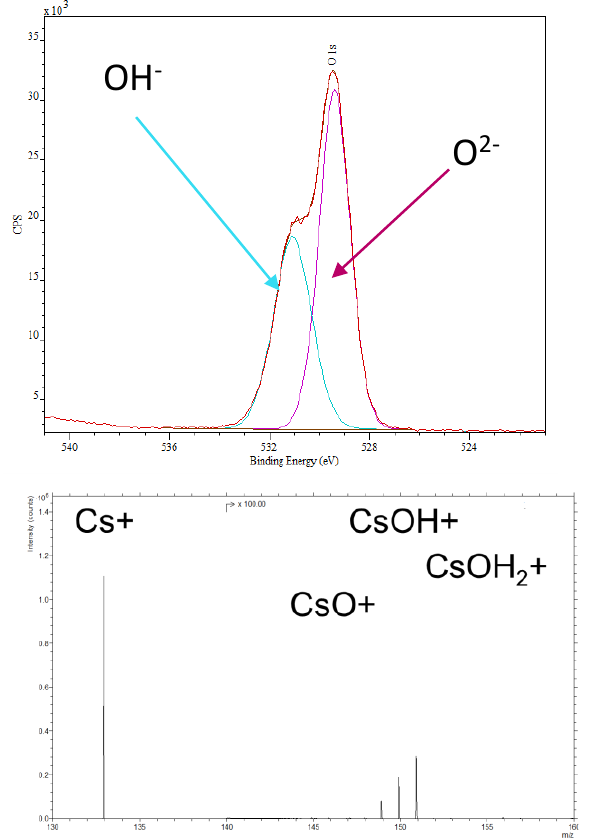
Figure 1: O 1s XPS and ToF SIMS spectra of CsI deposited on SS coupon after revaporization at 410°C in air/steam atmosphere